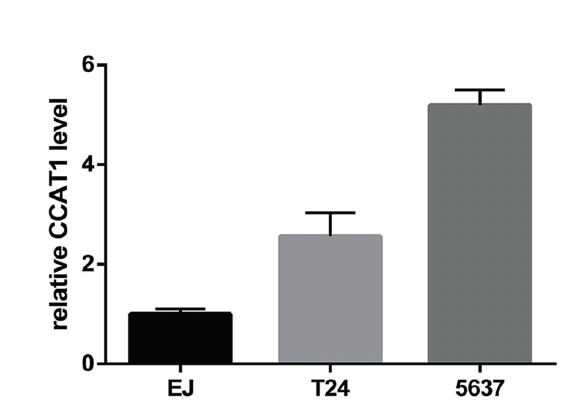
Supplemental Figure 1 - The expression level of CCAT1 in EJ, T24, 5637 cell